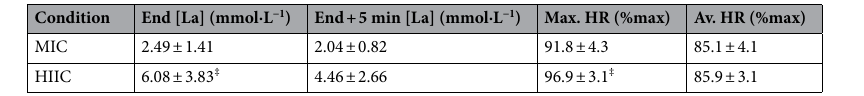
Table 1. Physiological response to the MIC and work-matched HIIC protocols. Values presented as mean ± SD. MIC moderate intensity cycling; HIIC high intensity interval cycling; [ La ] blood lactate concentration; HR heart rate; max . maximum; av . Average. ‡ Significantly greater than MIC ( p < 0.05).